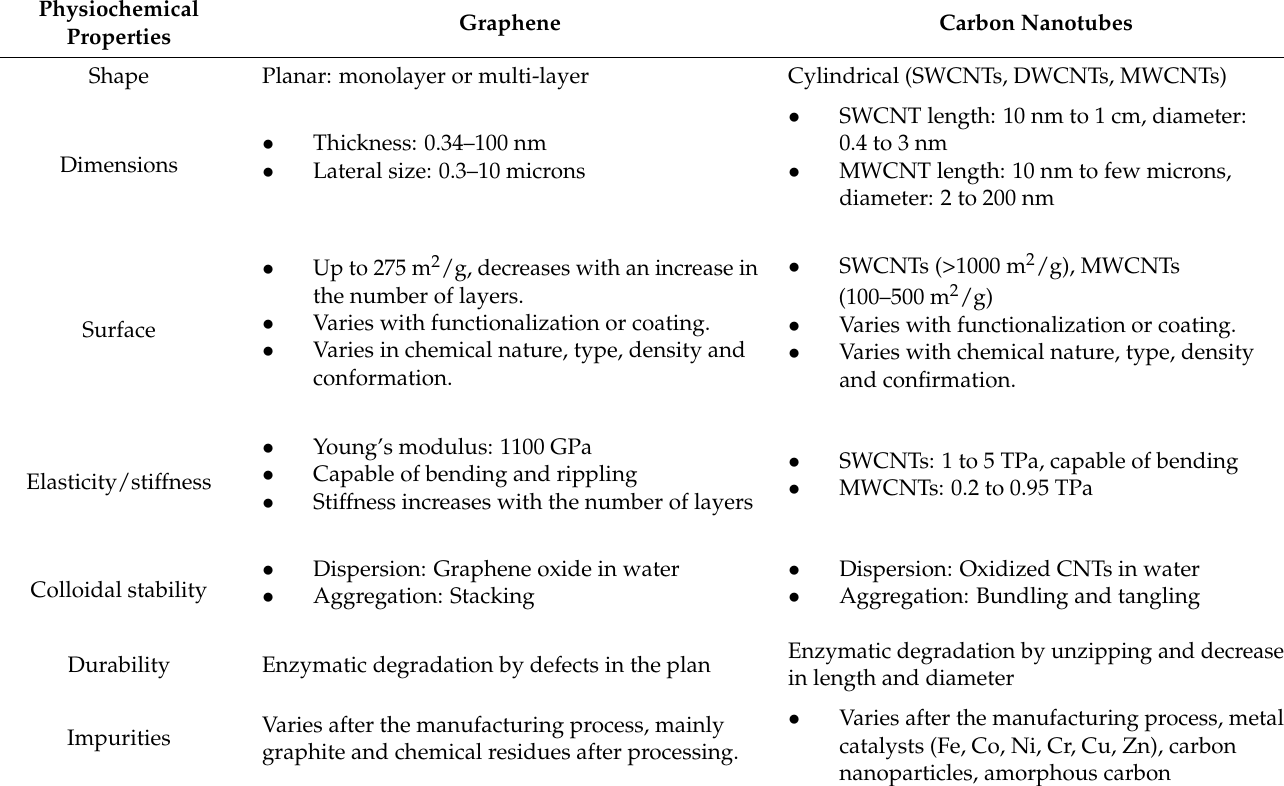
Table 1. Comparison between CNTs and graphene based on certain physicochemical properties [78].